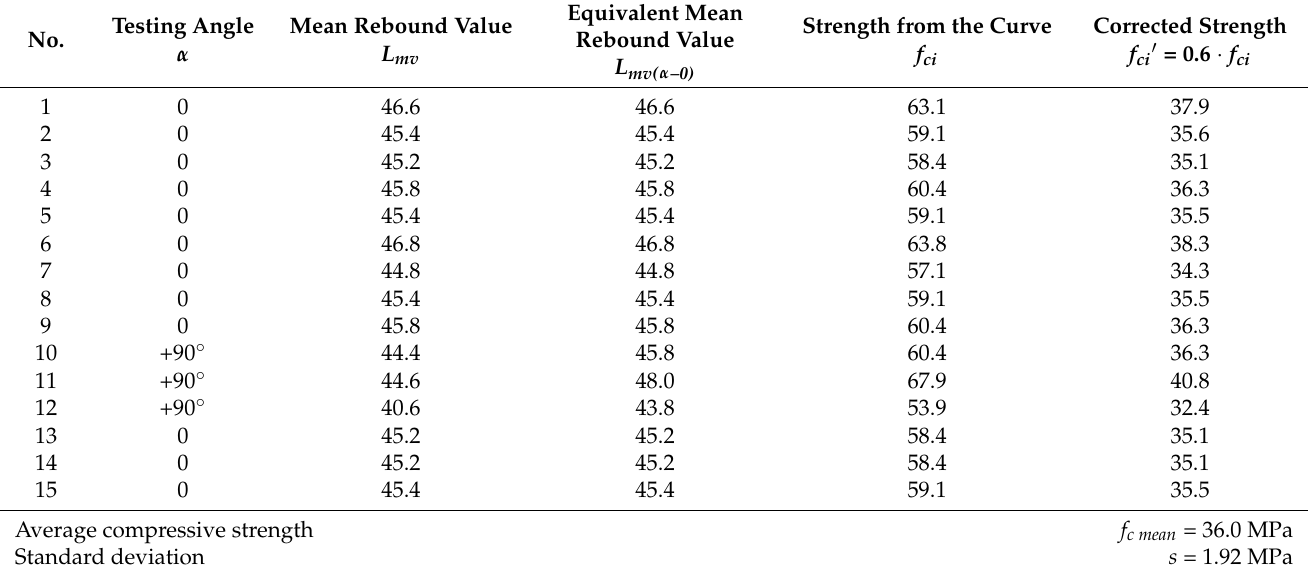
Table 2. Sclerometric test results (girder G11, Hall